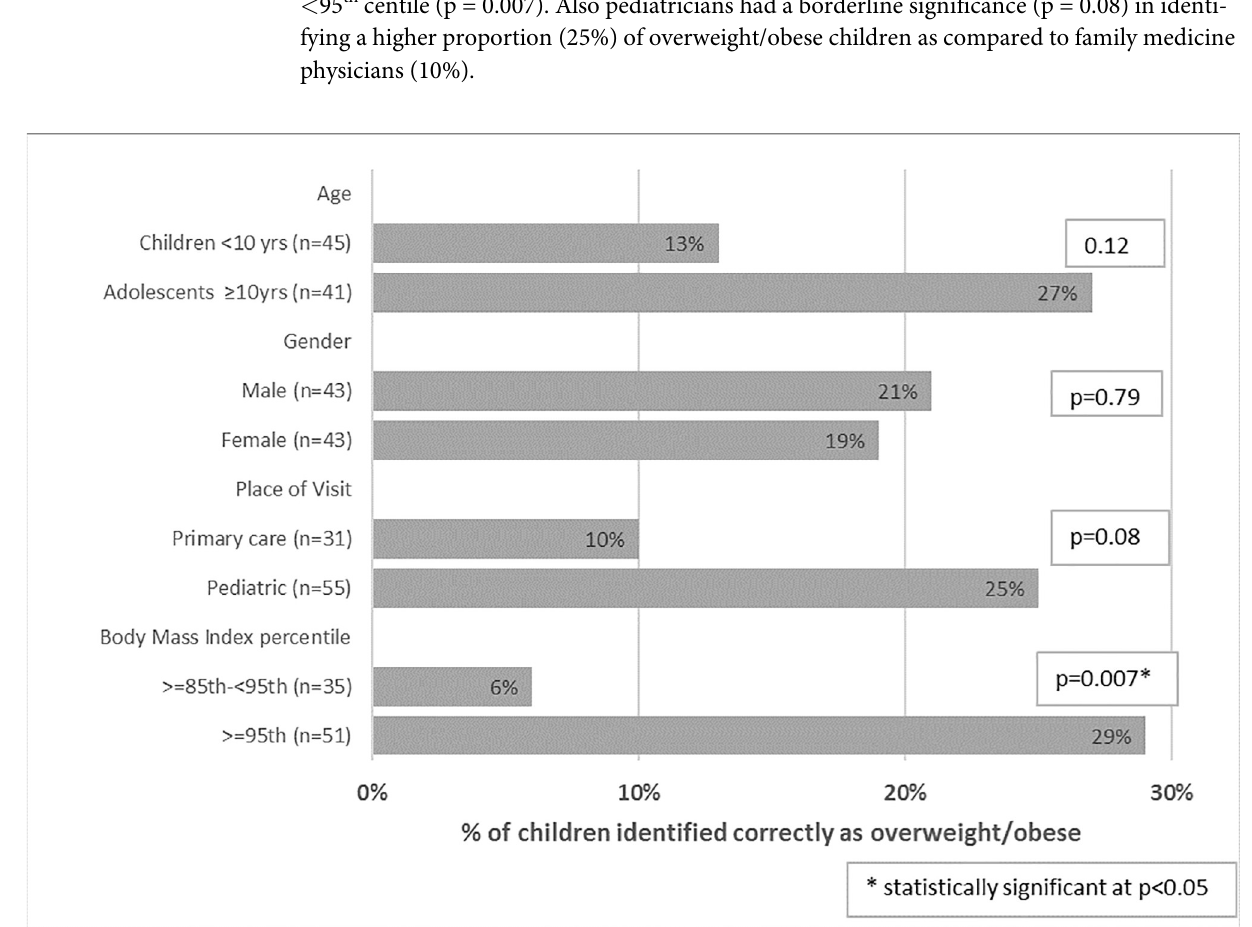
Fig 1. Physician identification of overweight/obese status of patients by covariates (N = 86). � After applying a Bonferroni correction on α � 0.05, statistical significance is α � 0.013.